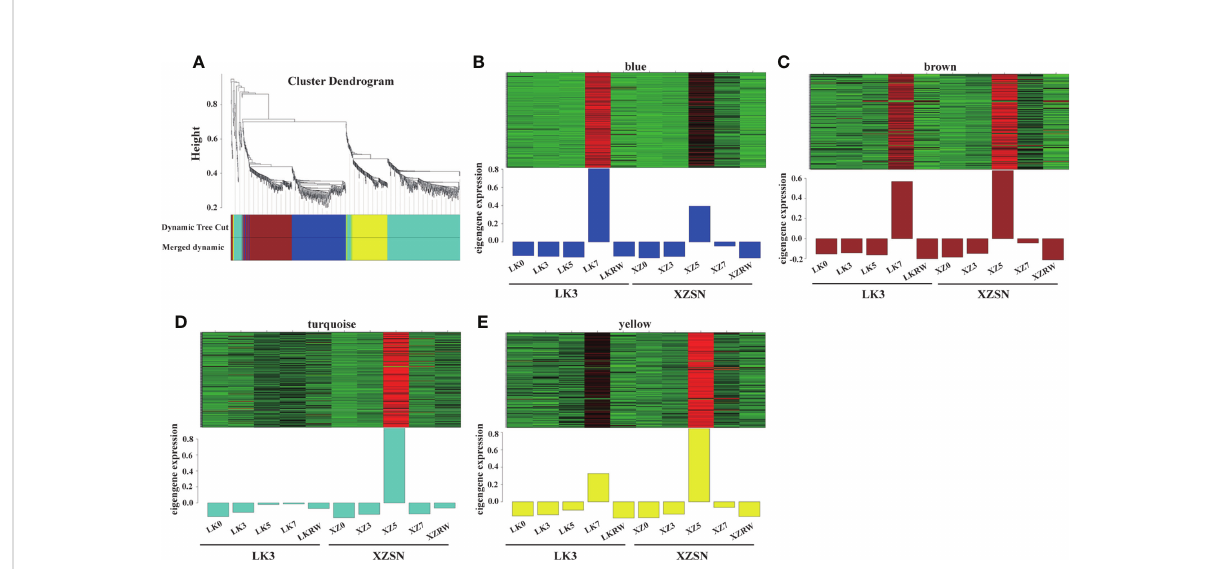
FIGURE 8 Co-expression network of the 1,206 potentially positive drought-resistant genes in XZSN. (A) Hierarchical clustering tree (dendrogram) of all genes. (B) Blue module, (C) brown module, (D) turquoise module, and (E) yellow